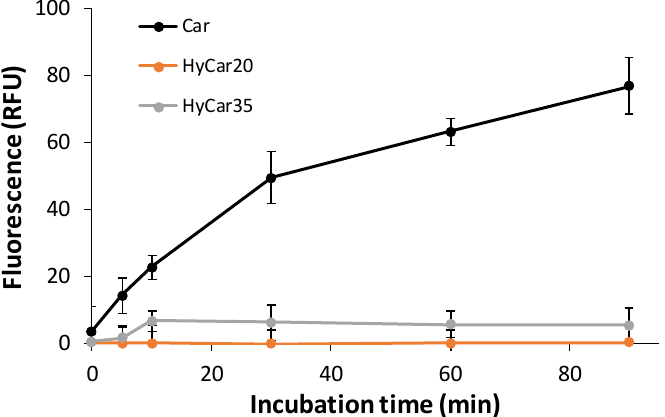
Figure 4. Carnosinase-mediated hydrolysis of Car, HyCar20 and HyCar35. The fluorescence inten- sity (proportional to the histidine content) is reported over reaction time. RFU: Relative Fluorescence Units.